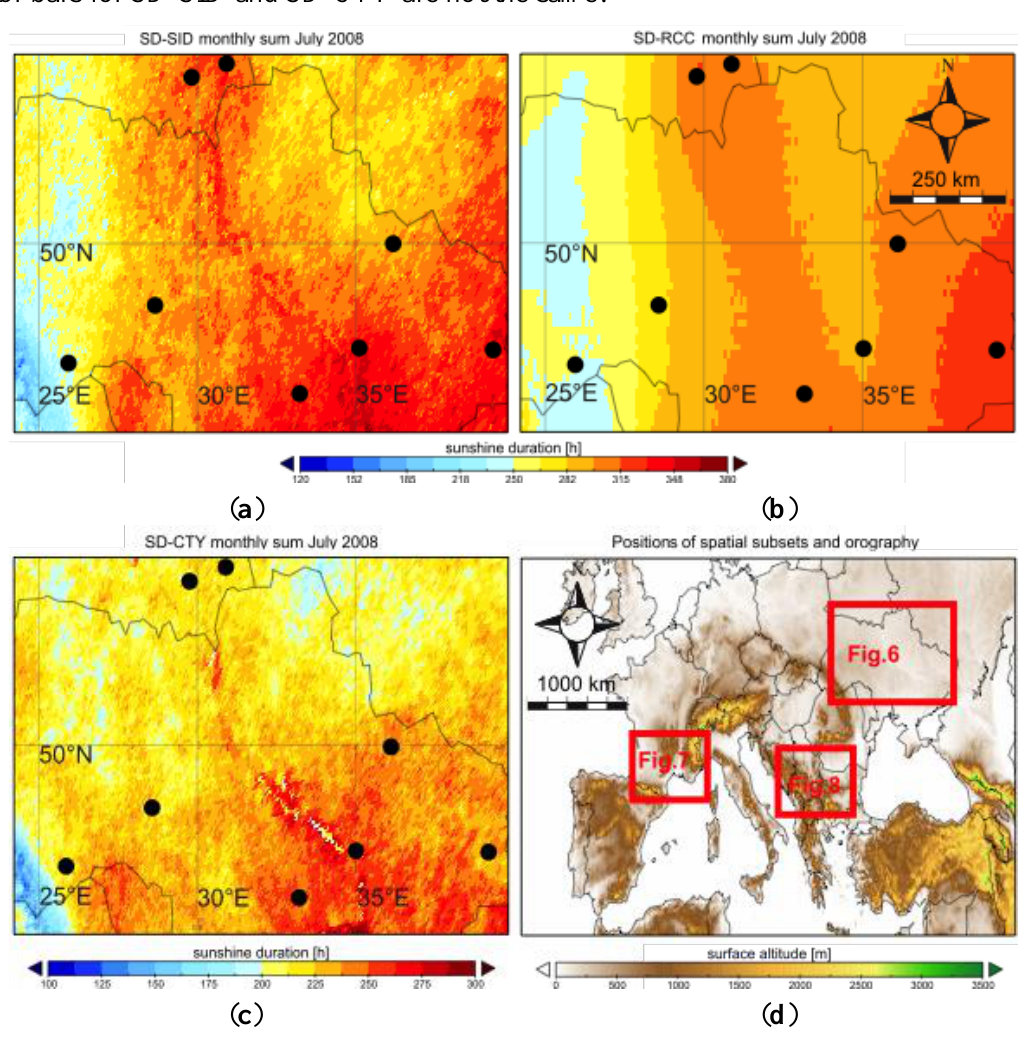
Figure 6. SD-SID ( a ), SD-RCC ( b ), and SD-CTY ( c ) for July 2008. ( d ) illustrates the positions of the spatial subsets in Figures 6 to 8. In order to show the spatial features, the color bars for SD-SID and SD-CTY are not the same.